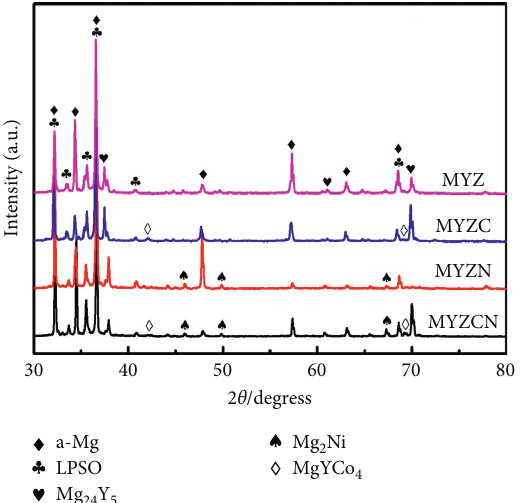
Figure 2: XRD patterns of as-cast MYZ, MYZC, MYZN, and MYZCN